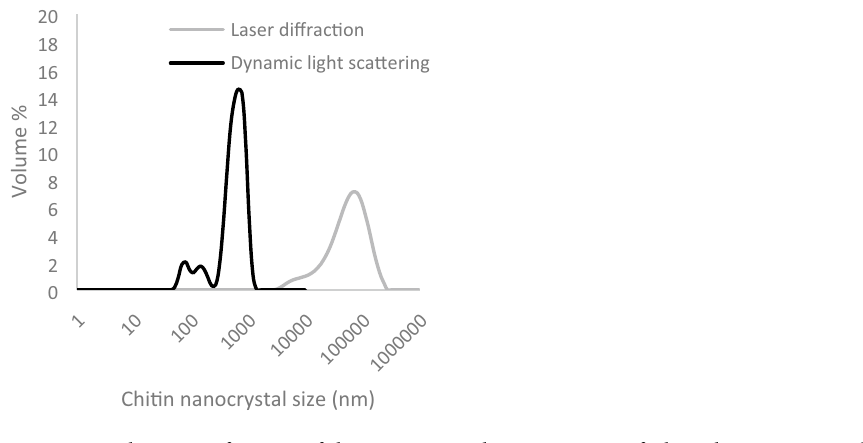
Figure 1. Volume % as function of chitin nanocrystal size at an E input of 0 kJ/g chitin nanocrystals measured with laser diffraction and dynamic light scattering. The average of three measurements is